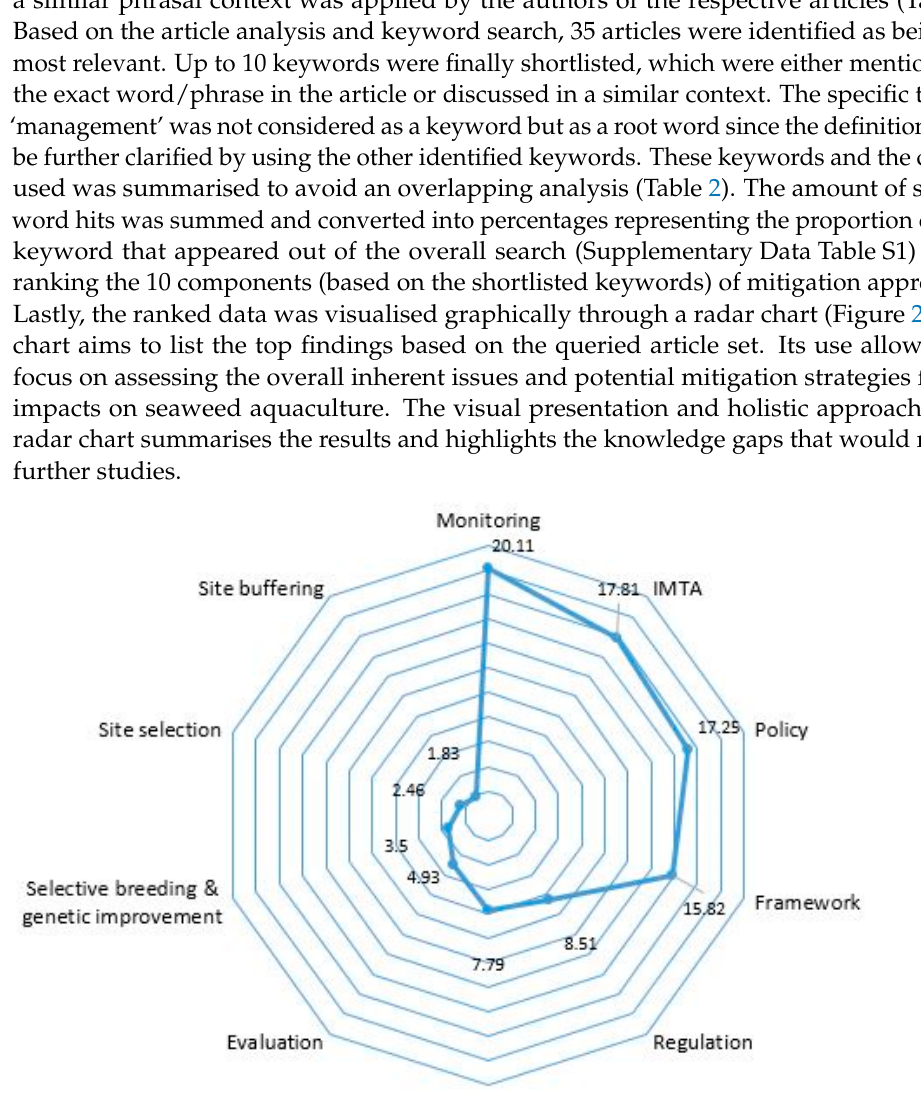
Figure 3. A conceptual diagram, which consists of various aquaculture aspects aimed at sustaining the productivity of aquacultured seaweeds under OA scenarios. 3. Ocean Acidification and Seaweeds’ Photosynthetic Rates and Nutrient Uptakes When seaweeds with different photosynthetic capacities are exposed to increasing oceanic CO 2 concentrations, biochemical and molecular changes cause varying carbon up- take capacities [39]. This has various implications in terms of alterations in the physiolog- ical responses of aquacultured seaweeds (Table 1). Seaweeds that solely obtain CO 2 through diffusive uptake are usually known as non-carbon concentrating mechanism